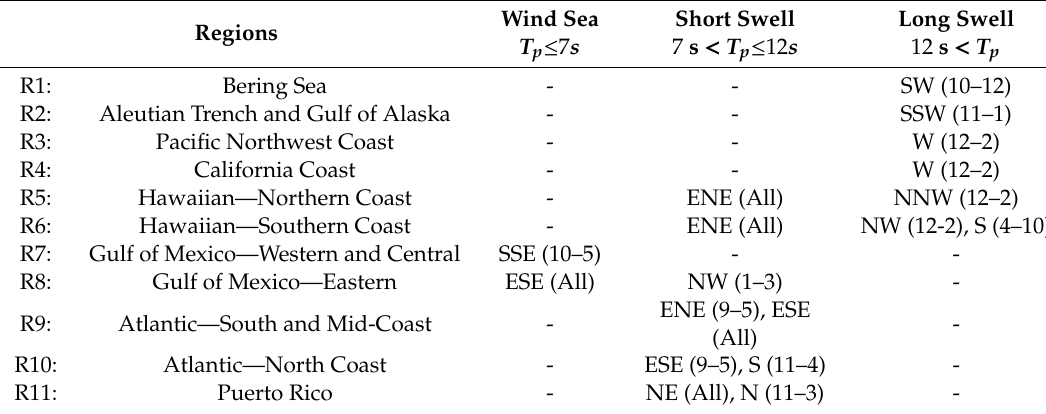
Table 1. Summary of the characteristics of the dominant wave systems (marked with the black bold box in Figures 2–12) in US wave energy regions. Three columns delineate the wave systems based on the peak period, with wave direction, and month in